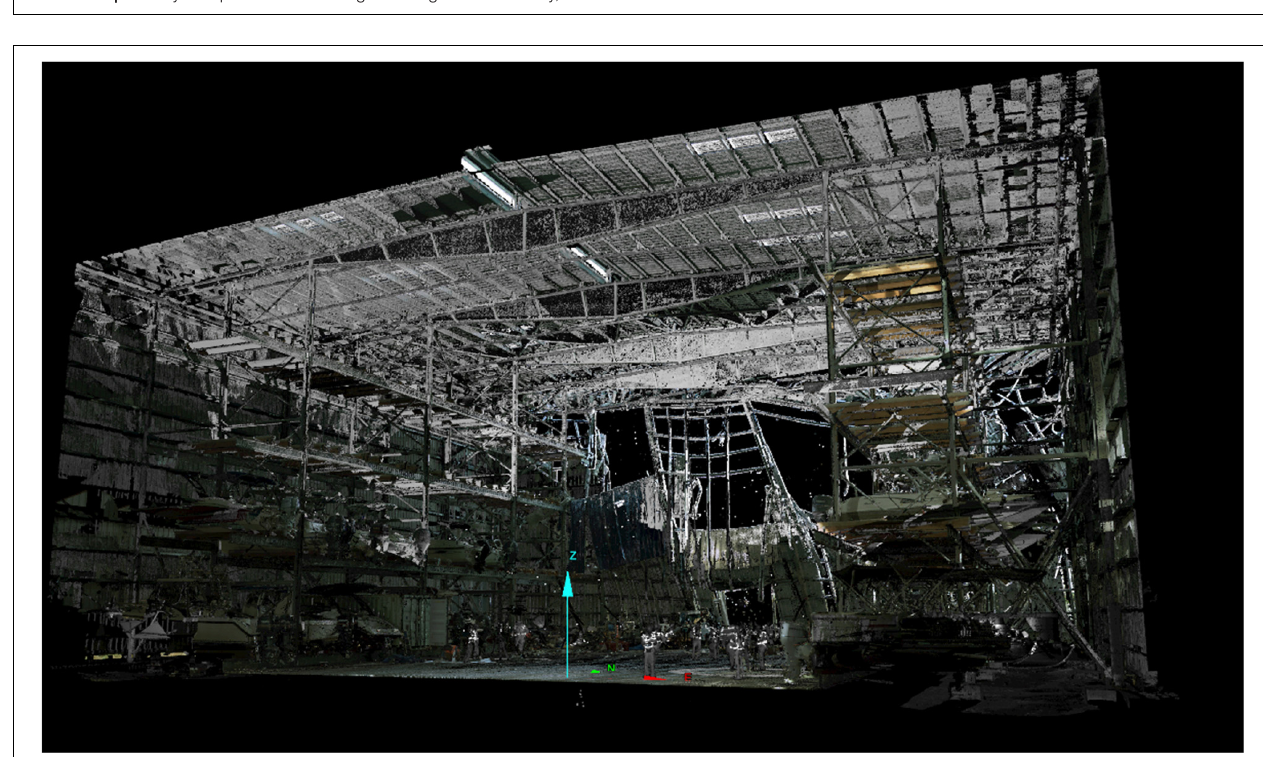
FIGURE 6 | 3D point cloud from lidar scans of the interior of the damaged marine storage building before cleaning (removal of debris to expose the structural